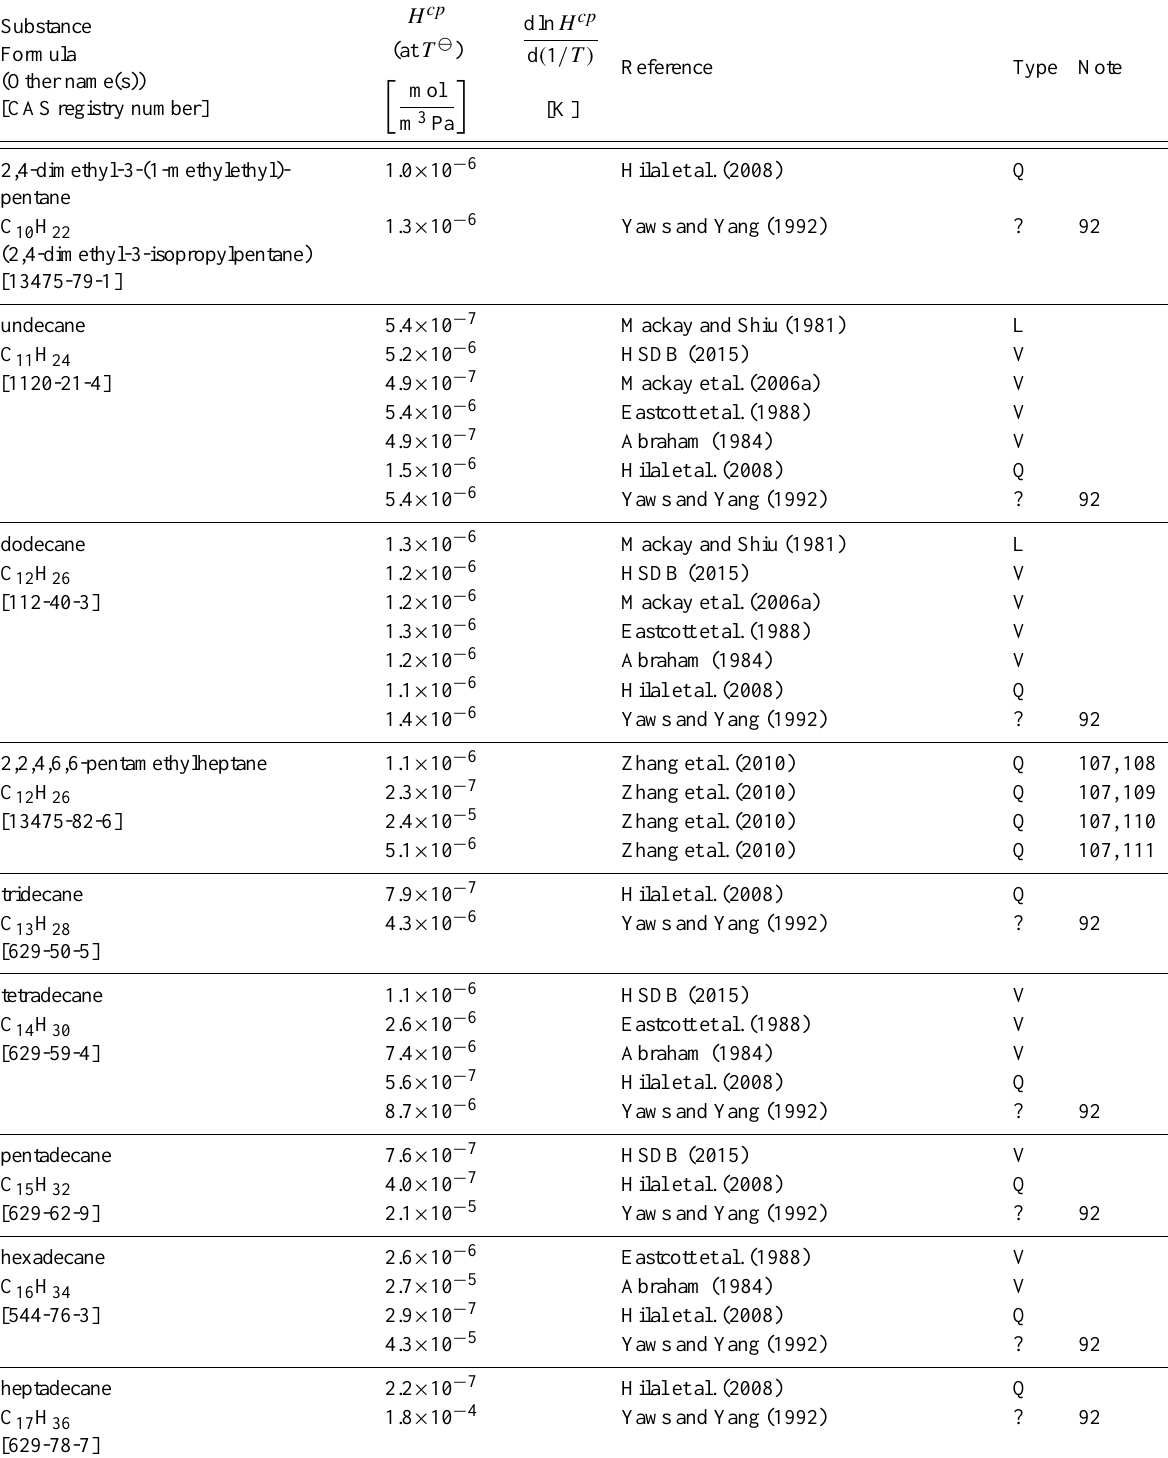
Table 6: Henry’s law constants for water as solvent